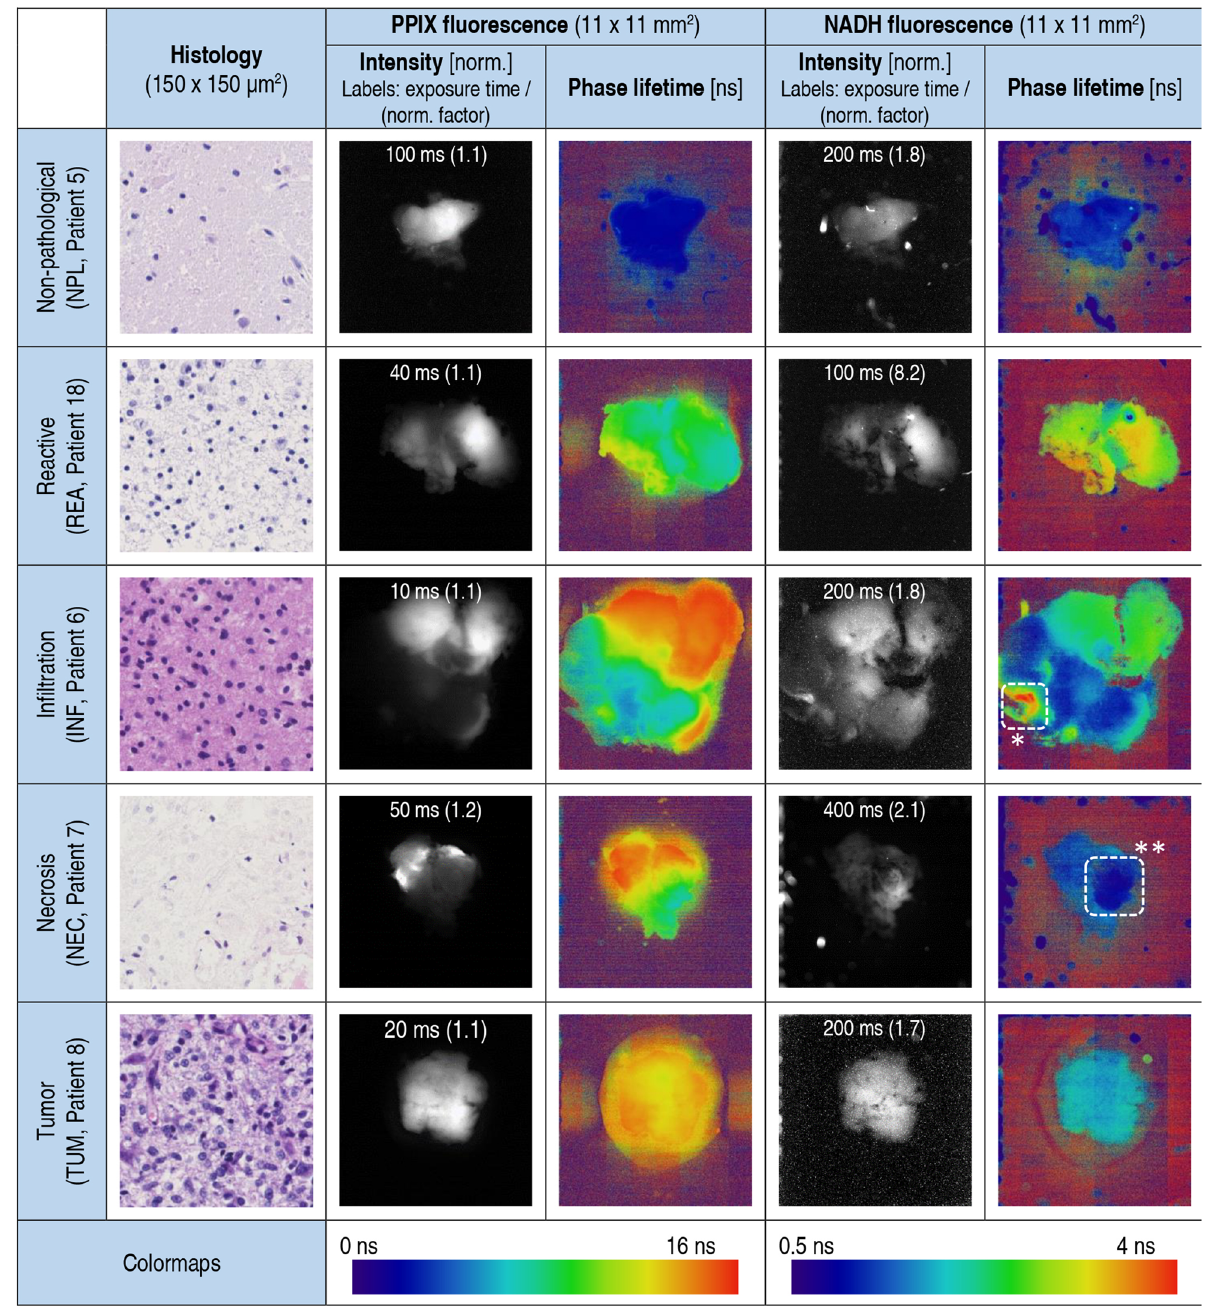
Figure 1. Representative NADH and PPIX fluorescence intensity and lifetime maps of tumor tissue with corresponding histology – Here we show fluorescence lifetime imaging of five representative brain tumor samples with different histopathological features. They were each obtained from a different patient as shown in Table 1. Fluorescence imaging of NADH and PPIX was performed with the pco.FLIM camera at 405 nm excitation. The fluorescence measurements (column 2–4) were performed at varying exposure times depending on the fluorescence yield (see labels in intensity images). The intensity images were then normalized for better contrast using the given normalization factor. The fluorescence lifetime maps were obtained from the phase delay relative to the modulated laser excitation. As reference we obtained histological sections for each sample investigated (see column 1). As shown malignant tissue is associated with increased NADH and PPIX fluorescence lifetime compared to non-pathological tissue. While pure fluorescence intensity imaging also shows major tumor infiltration areas, the fluorescence lifetime maps offer a more robust visualization of low fluorescing tissue. (Region of interests: *Very high NADH fluorescence lifetimes were characteristic for vessels found in histology. **NADH lifetimes below 1 ns were only found in necrotic